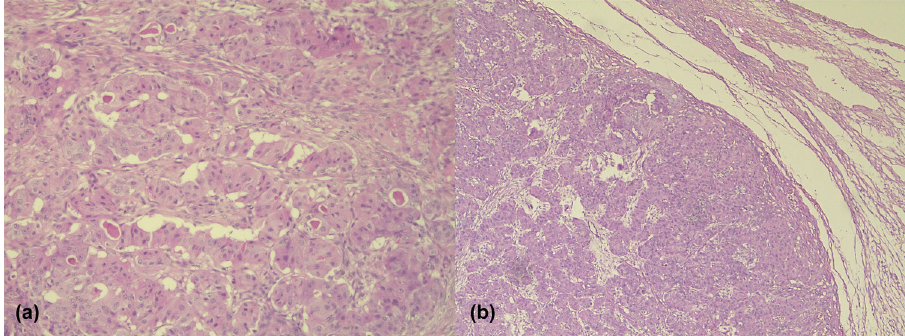
Figure 1: ( a ) Eosinophilic, colloid - like content in the lumen of tubular formation of the tumor cells ( HE, × 10 ) . ( b ) Expansive tumor growth toward the ovarian cortex ( HE, × 5 )